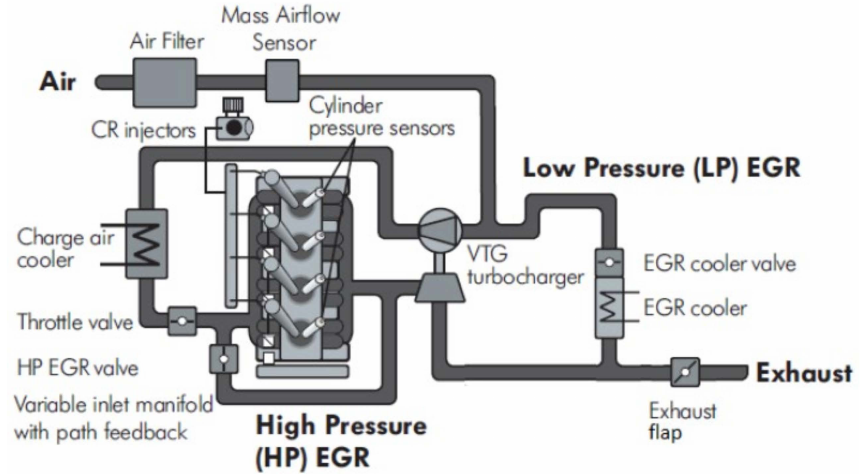
Figure 1. Engine